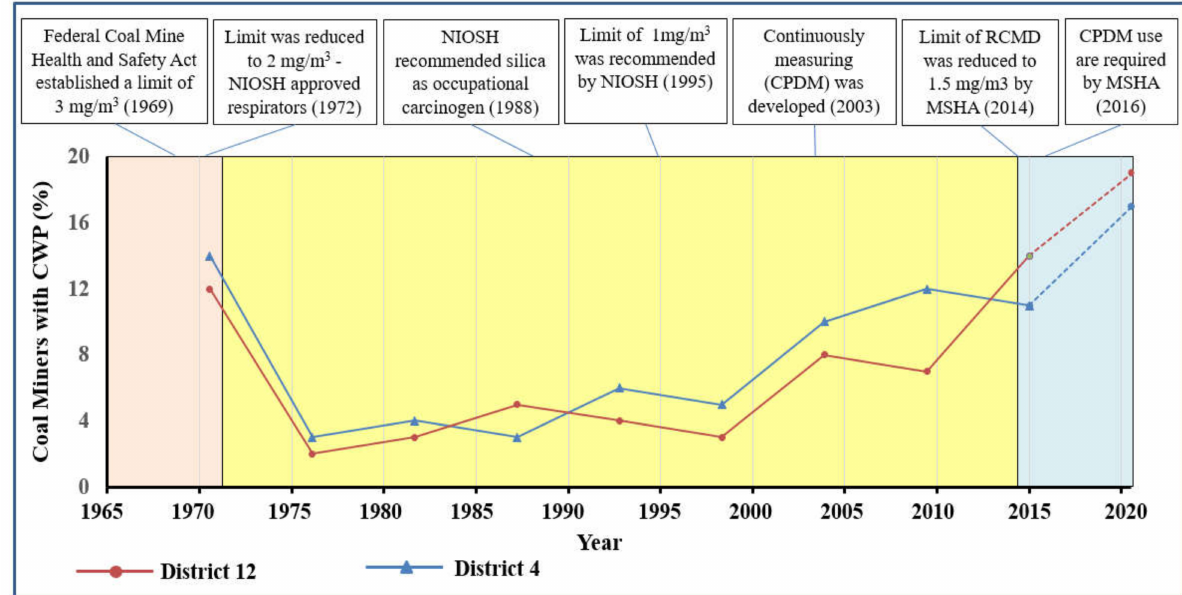
Figure 1. Coal workers’ pneumoconiosis (CWP) prevalence in mid-central (District 4, Southern West Virginia) and south- central Appalachia (District 12) underground coal miners between 1970 and 2014. Data acquired from the Coal Workers’ Health Surveillance Program (CWHSP) data query system [3,14], and includes all reported categories of CWP. CPDM: continuous personal dust